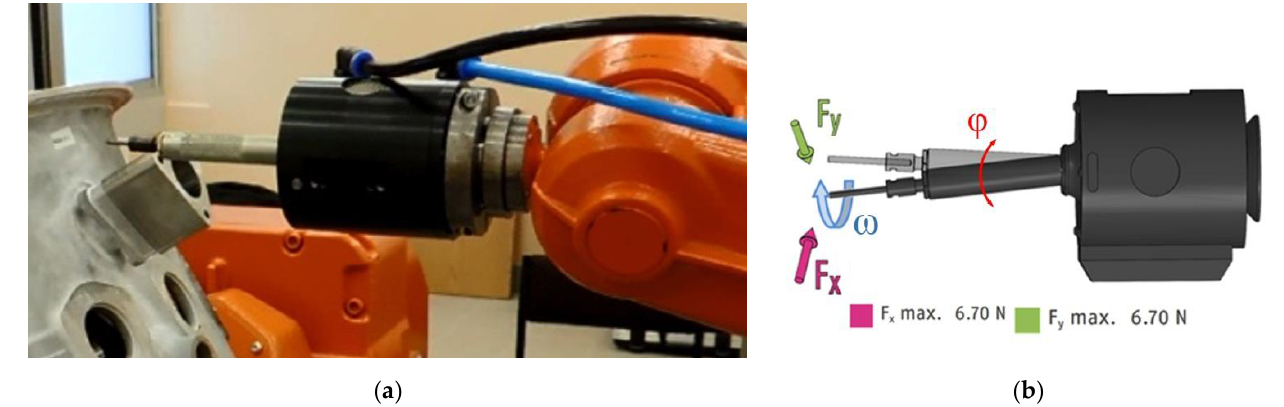
Figure 3. Deburring edges with a pneumatic tool with compliance: ( a ) view of the station; ( b ) the concept of a rotary file with pneumatic progression of the feed force.